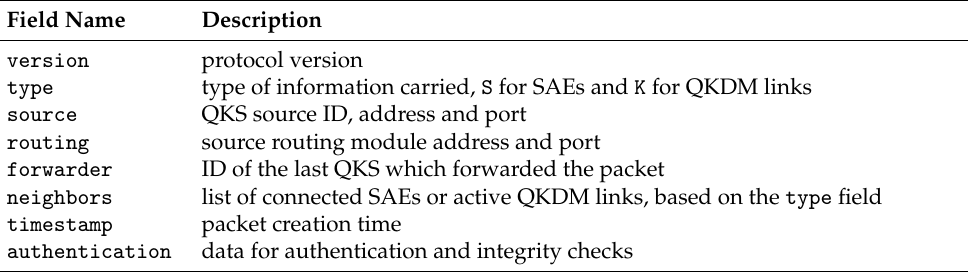
Table 2. Routing LSA packet